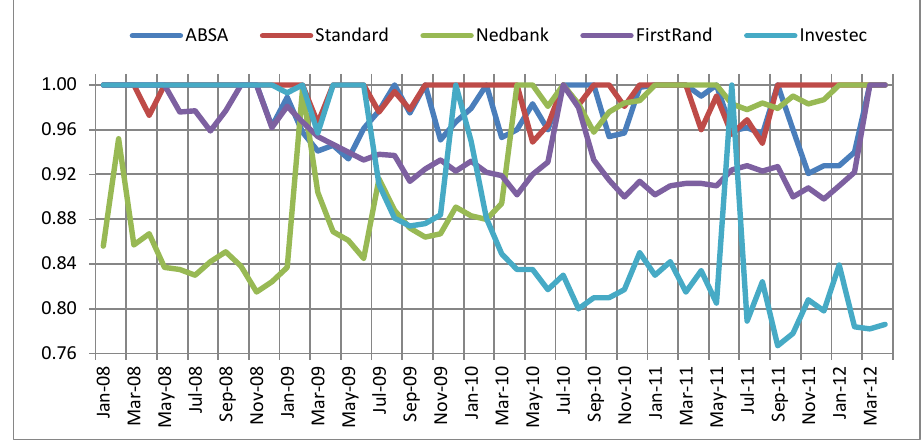
FIGURE 2: Comparison in terms of technical efficiency (input-orientated) Source: